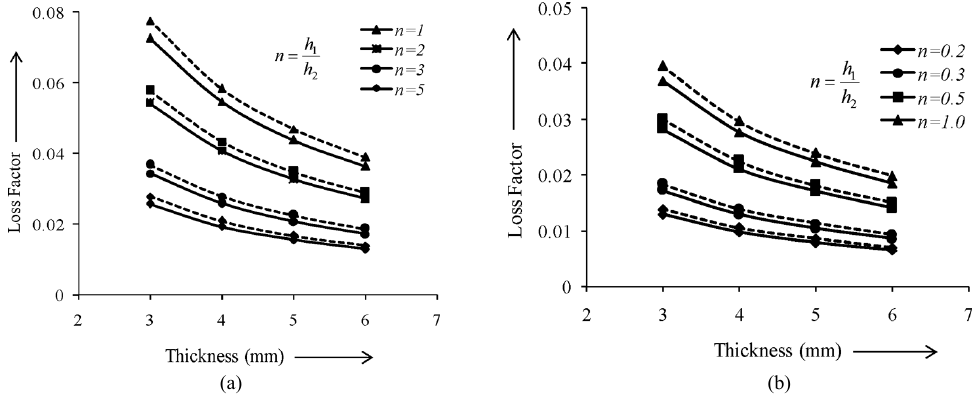
Fig. 11. (a) Variation of loss factor with amplitude for jointed and welded cantilever beams of dimensions = 600.6 × 40.2 × 6 mm 3 ; (b) Variation of loss factor with amplitude for jointed and welded cantilever beams of dimensions = 560.2 × 40.2 × 6 mm 3 .